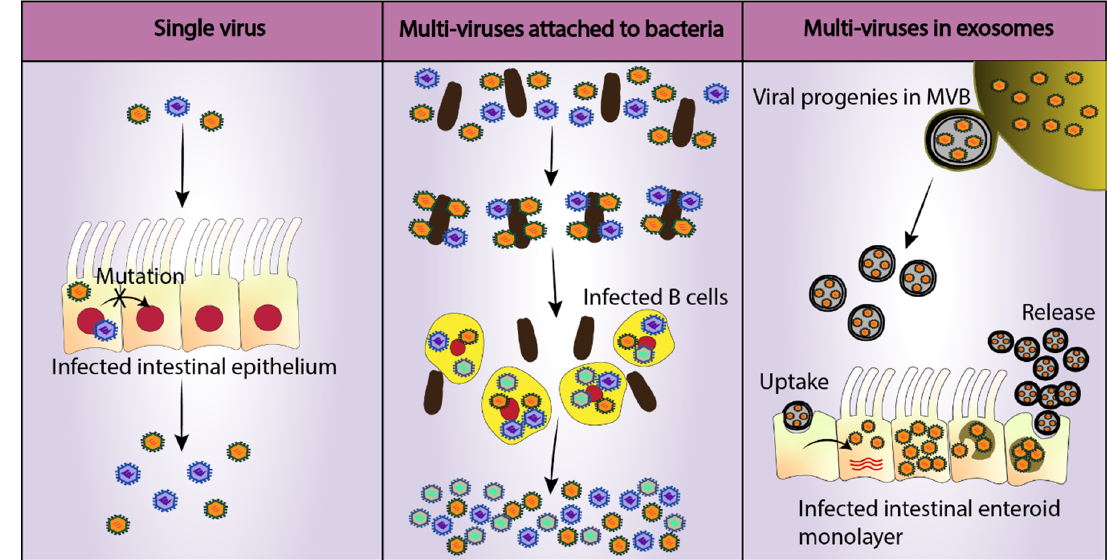
Figure 2. Viral mechanisms to increase the cellular multiplicity of infection (MOI). Single RNA viruses lack proofreading mechanisms diminishing the ability of the virus to undergo successful replication in its host due to the production of attenuating mutations [89]. On the other hand, infection of a single cell with multiple viruses increases infection efficiency and viral fitness [51]. Two such mechanisms have been identified in enteric viruses: Attachment to commensal bacteria (poliovirus) and egress in extracellular vesicles (rotavirus) [51,90]. A similar mechanism may be employed by HuNoV, which could explain enhanced B cell replication in vitro in the presence of enteric bacteria such as Enterobacter cloacae [12]. Noroviruses are also found inside multi-vesicular body (MVB) derived exosomes and cause higher infection as compared to single viruses of same MOI [51].